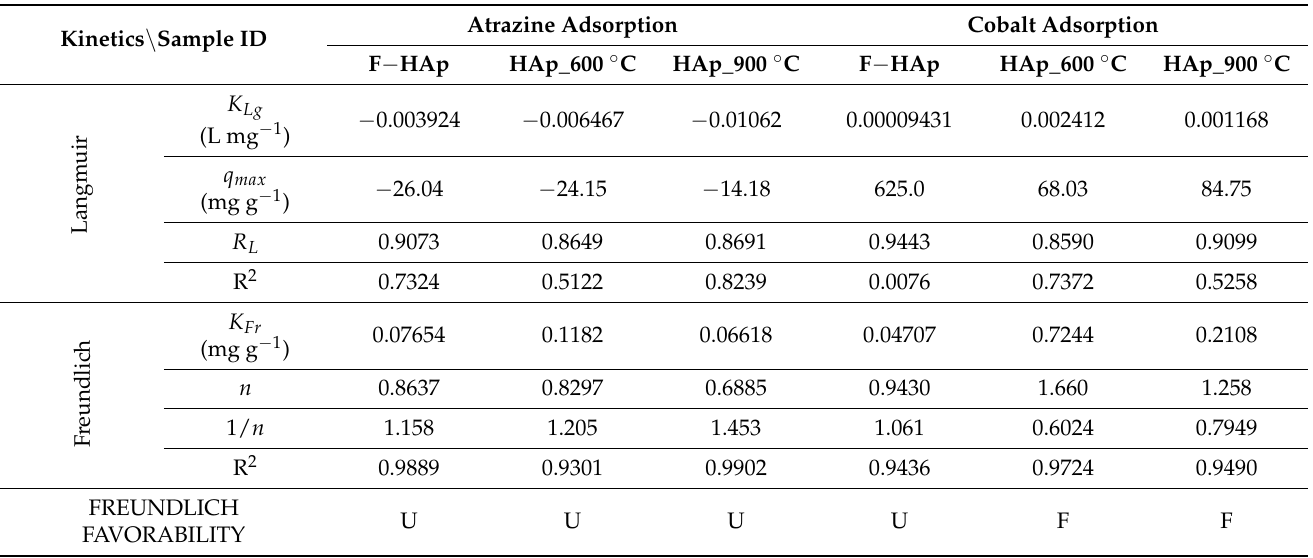
Table 7. Calculated Langmuir and Freundlich isotherm model parameters for all adsorbents (F − HAp, HAp_600 ◦ C, and HAp_900 ◦ C) and pollutants (atrazine and